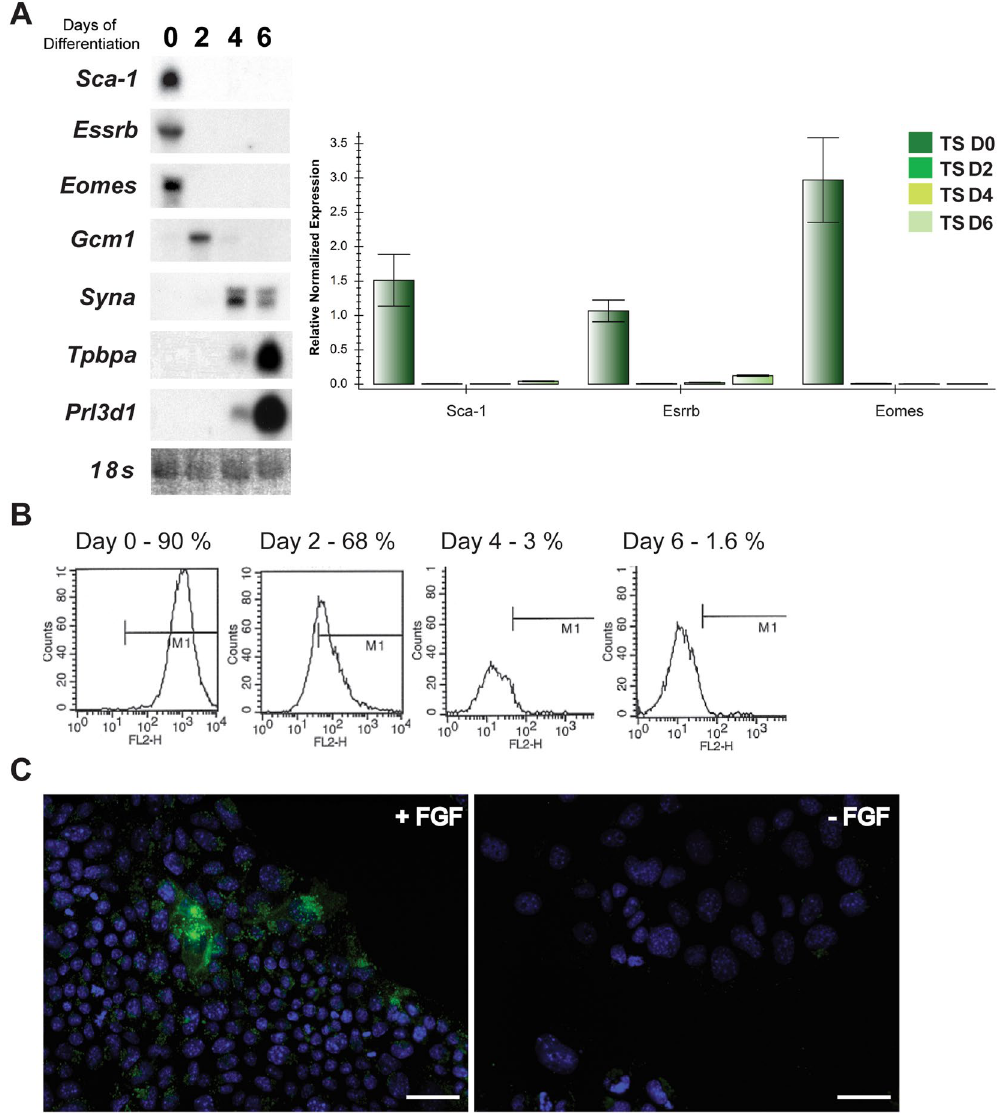
Figure 1. Sca-1 was determined to be highly expressed in undifferentiated TS cells in culture by Northern blot and qRT-PCR ( A ) and FACS analysis ( B ). Day 0/0 represents undifferentiated, proliferating TS cells while 2, 4, 6 and Day 2, Day 4 and Day 6 represent cultures differentiated for 2, 4 or 6 days. Sca-1 was also expressed in TS cells in culture as detected by immunofluorescence ( C ; + FGF) however became undetectable following differentiation ( C ; − FGF). Immunofluorescence in cells ( C ) in the presence and absence of FGF matched the pattern of expression observed by FACS ( B ), however was not obvious in as a high frequency ( + FGF) which is likely due to the more sensitive detection of Sca-1 expression by FACS. Scale bar = 100 um. Northern blot results shown in ( A ) are cropped and organized to be presented as a composite from multiple